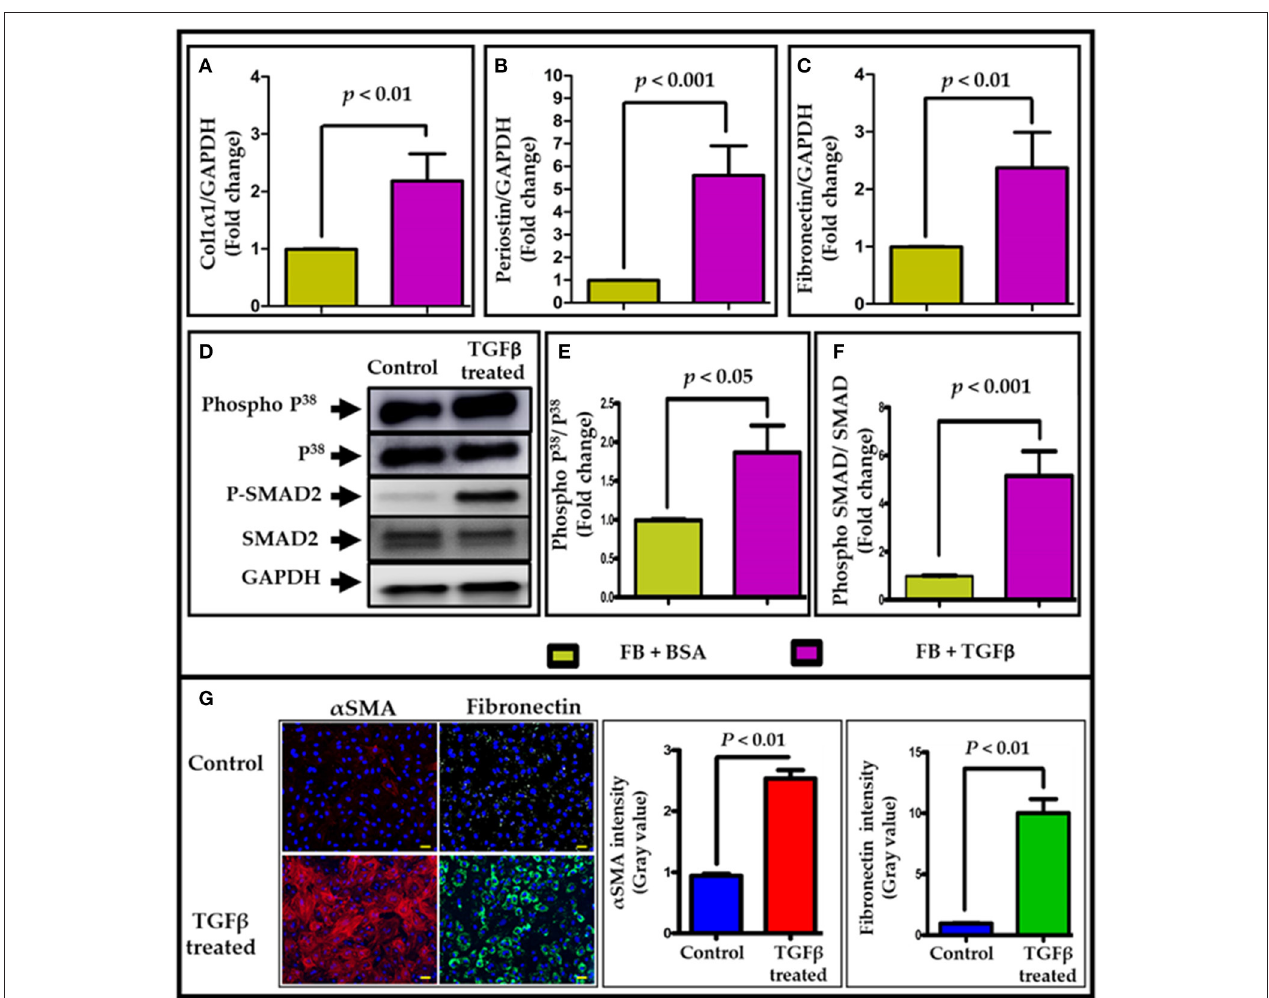
FIGURE 1 | TGF β treatment activates cardiac fibroblasts. TGF β treatment significantly upregulated pro-fibrotic genes expression, including (A) collagen1 α (Col1 α ), (B) periostin (Postn), and (C) fibronectin (Fn1) in NRVF cells. In addition, an increased phosphorylation of p38 and SMAD2 (D–F) was observed in TGF β -activated NRVFs. GAPDH was used as loading control for both mRNA and protein expression analysis. (G) Immunostaining of BSA and TGF β -treated fibroblasts with α SMA (red)/fibronectin (green)/DAPI (blue). Fibrotic markers were significantly upregulated upon TGF β treatment. Images (G) were taken at 400X and scale bar is 100 µ m. P < 0.05 was considered as statistical